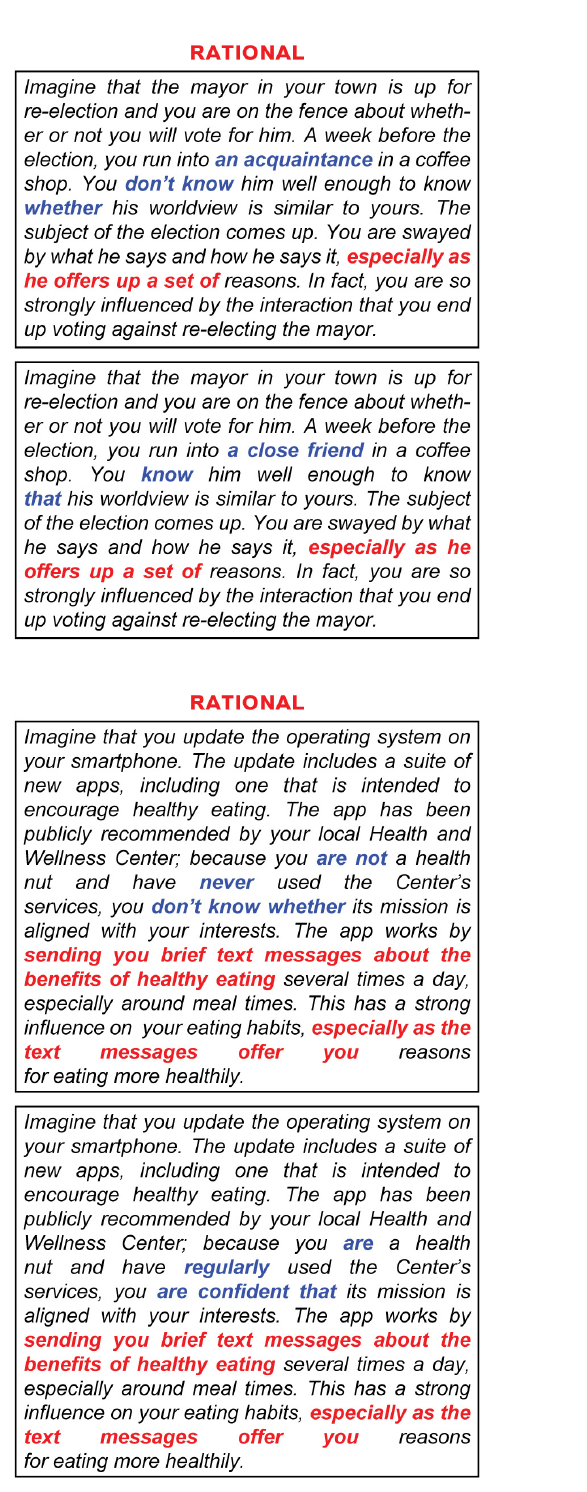
Frontiers in Psychology |